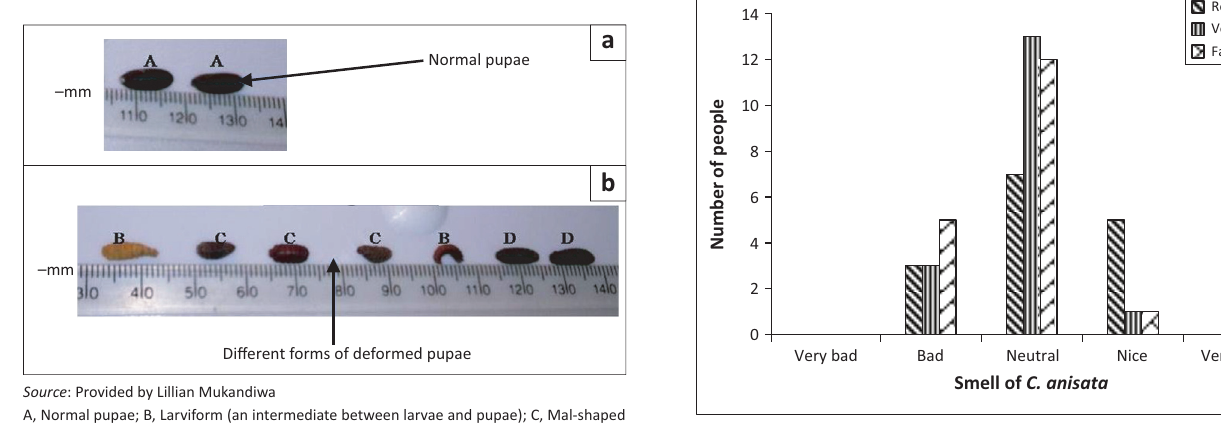
FIGURE 3: (a, b) Different forms of abnormal pupae emerging from the test farm (B–D) compared to the normal pupae from the control farm (A).